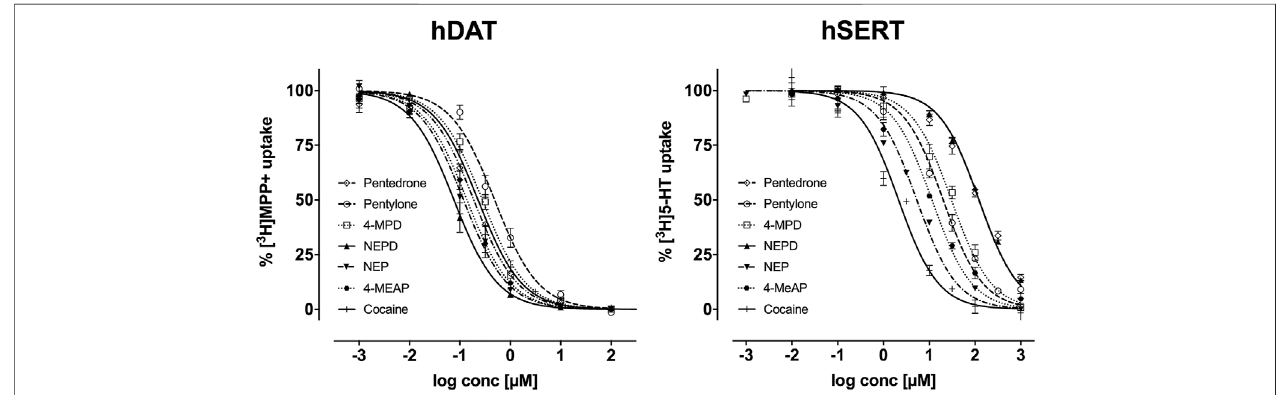
Frontiers in Pharmacology |